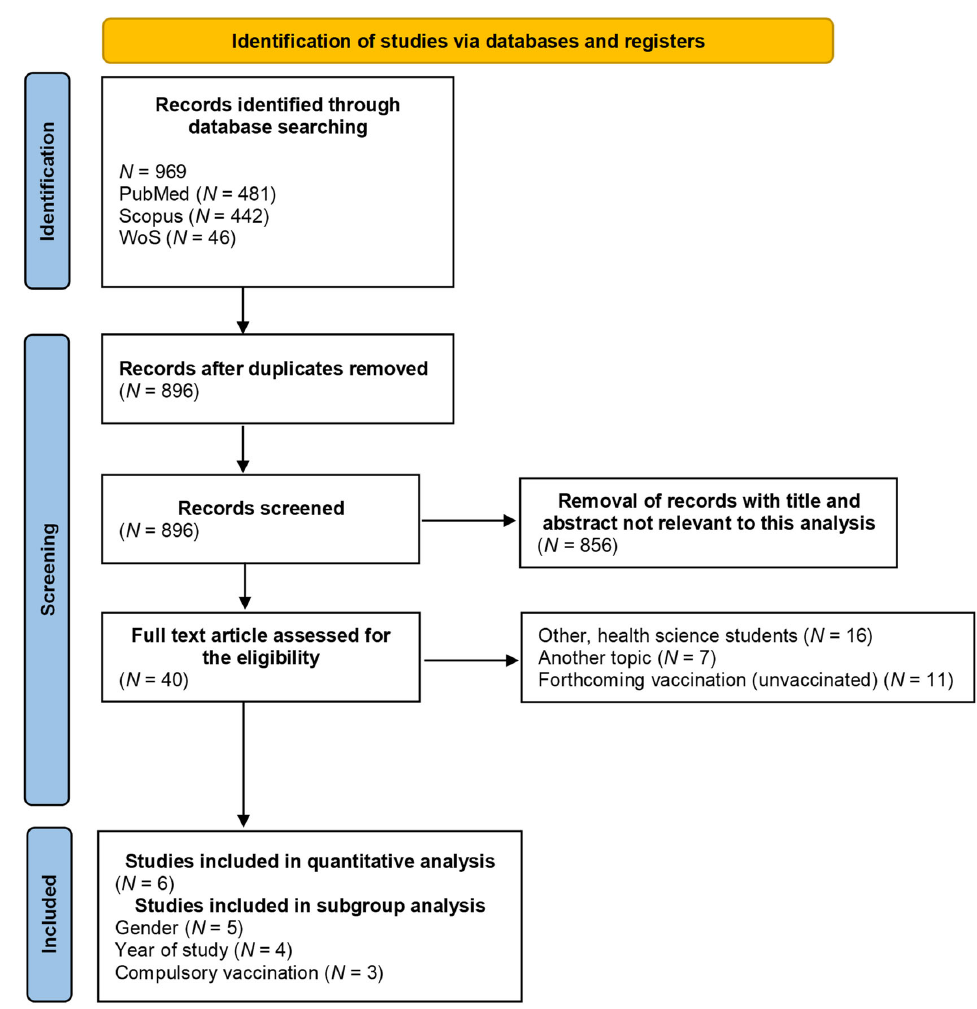
Figure 1. PRISMA flow diagram of screening process.